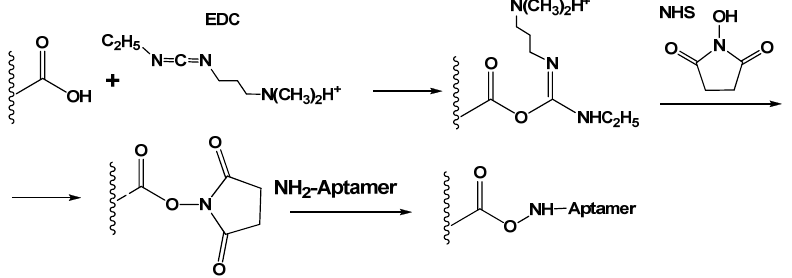
Figure 6. Principal scheme of the EDC-NHS-based carbodiimide binding of aminated aptamer to carboxylated carrier.